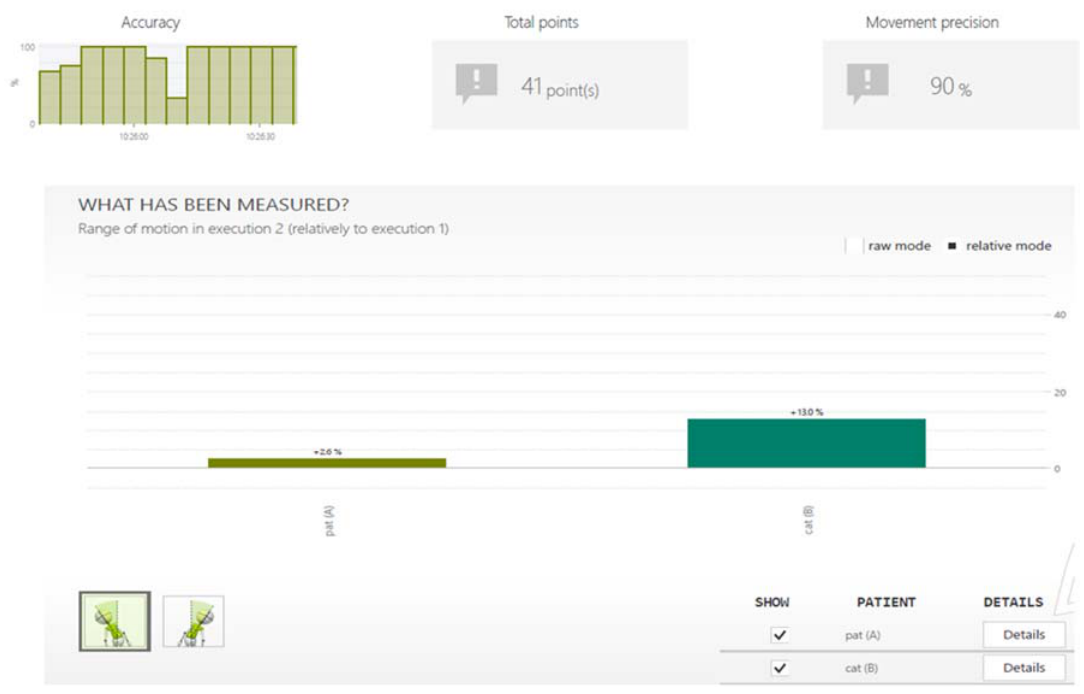
Figure 4. Sample analysis of results for the game fish. Sensors 2020 , 20 , x FOR PEER REVIEW